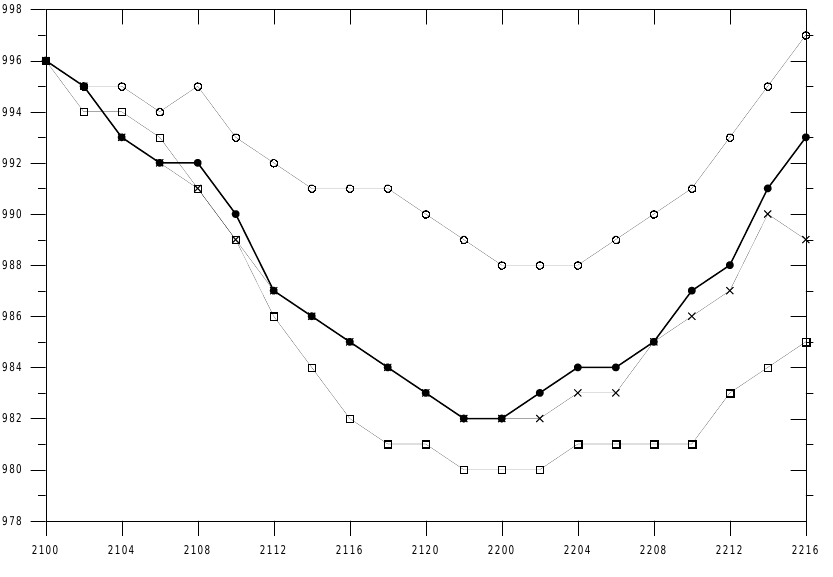
Fig. 14. Central surface pressure (hPa) for the cyclone as simulated by the C21–23 (filled circles), NT21–23 (squares), NSH21–23 (crosses) and NLH21–23 (empty circles) simulations for the period from 00:00UTC, 21December to 16:00UTC, 22December1979. Date labels are presented in DDHH